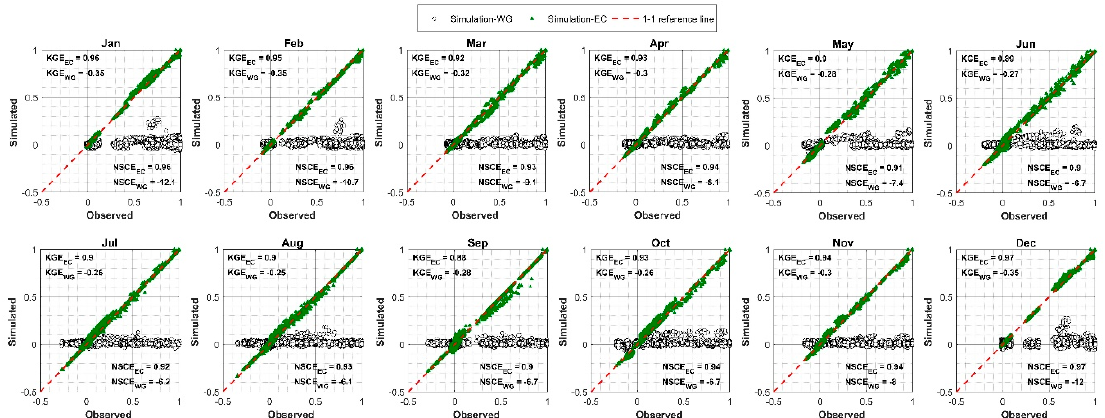
Figure 11. Performance evaluation for empirical copula (EC) and weather generator (WG) models for preserving the spatial and cross correlations of the weather variables for each month.